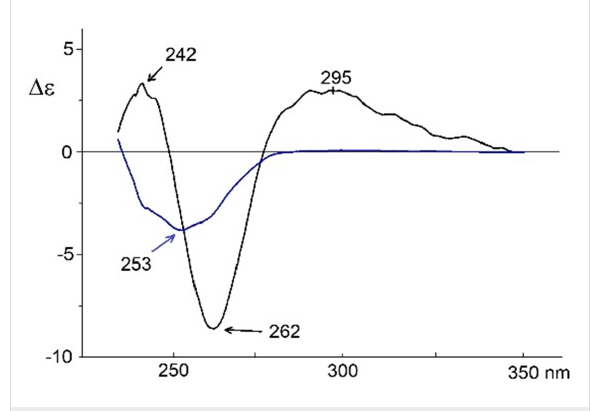
Figure 6: CD spectra of compound 10 ( cis ) in DMSO/H 2 O (1:2, v/v) in solution (in black) and as gel (in blue).